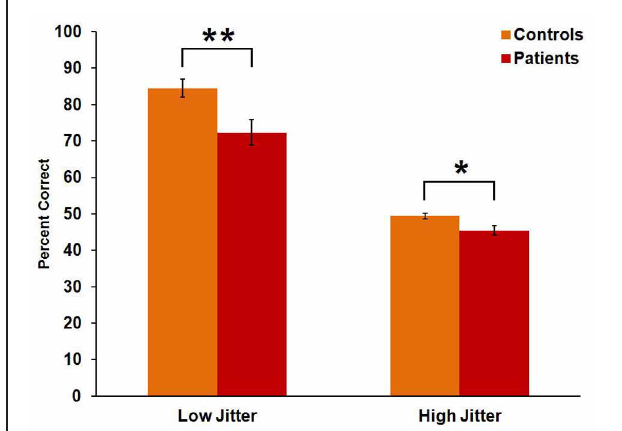
FIGURE 2 | Behavioral performance of controls and patients in low- and high-jitter conditions. ∗ p < 0 . 05, ∗∗ p < 0 .